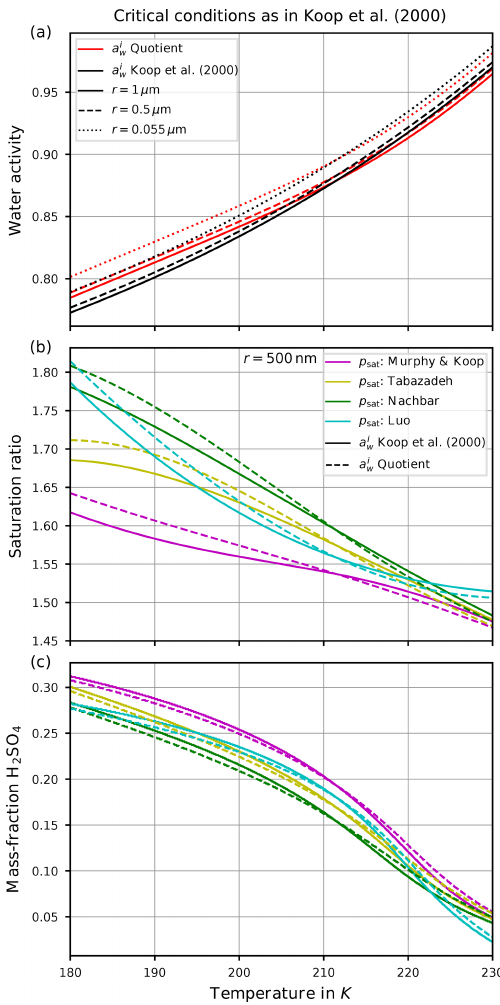
Figure 5. Critical conditions for the freezing threshold computa- tions motivated by Koop et al. (2000). The curves designated as “ a i w Koop et al. (2000)” refer to the computations with a i w taken from Koop et al. (2000), whereas the curves designated as “ a i w Quo- tient” indicate the computation of a i w as the quotient of saturation pressures (Eq. 3). Panel (a) shows the critical value of the water activity for various sizes of the spherical solution particles. Panel (b) comprises the critical saturation ratio, i.e., converting the critical water activities from panel (a) into a saturation ratio as in Eq. (4). Panel (c) shows the required mass fraction to realize the critical value of the water activity shown in panel (a)